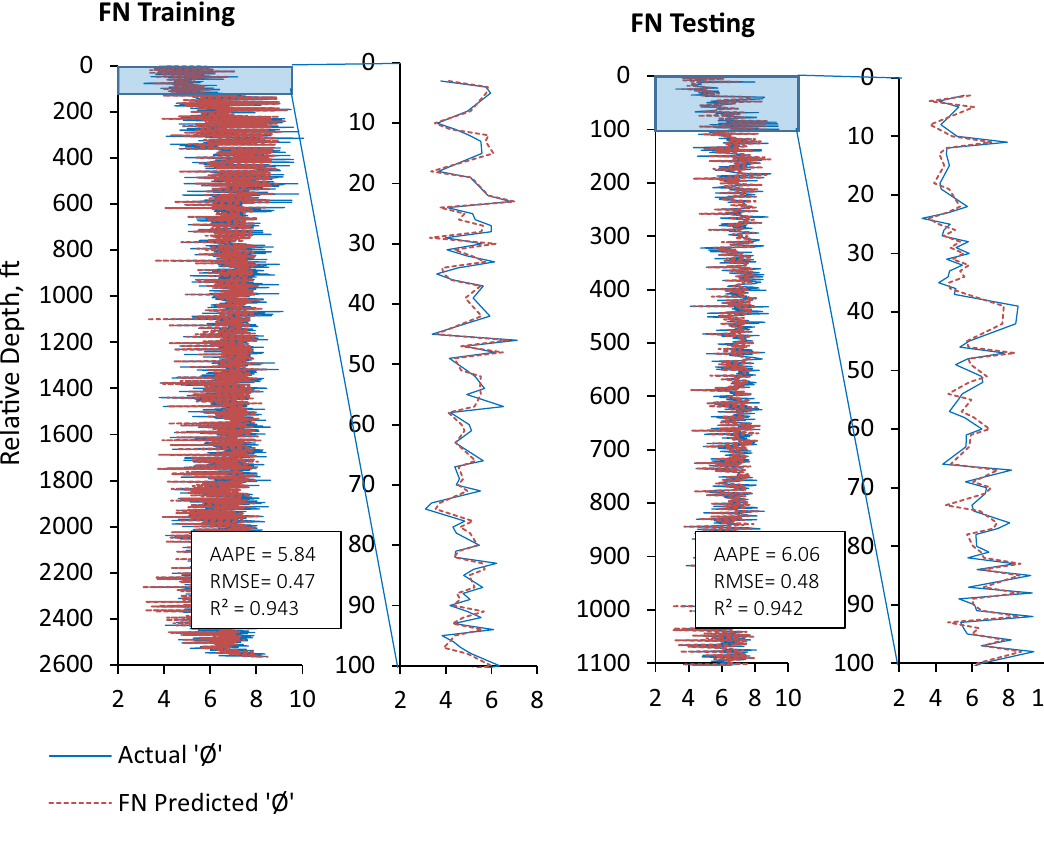
Figure 12. Comparison of training and testing results of FN model with actual Φ NMR .